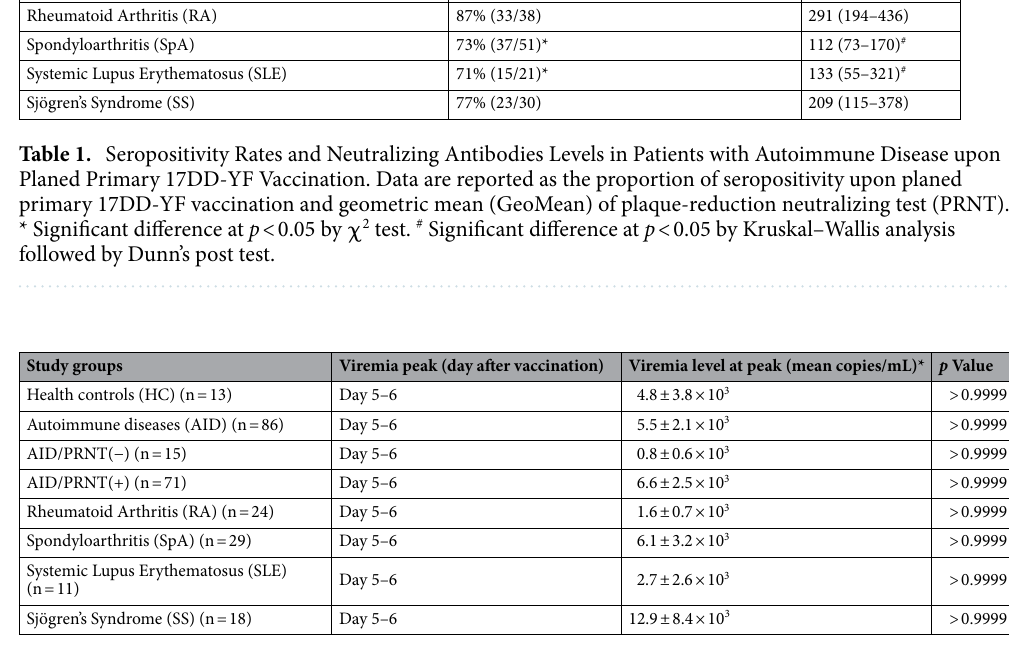
Table 2. Viremia Levels in Patients with Autoimmune Disease upon Planed Primary 17DD-YF Vaccination. * Data are reported as mean copies of 17DD-YF RNAnemia at peak ± standard error. No significant difference by no-parametric Kruskal–Wallis analysis ( p = 0.5056) followed by Dunn’s post-test for sequential pairwise comparisons and a threshold p value of < 0.05 was considered for statistical significance.